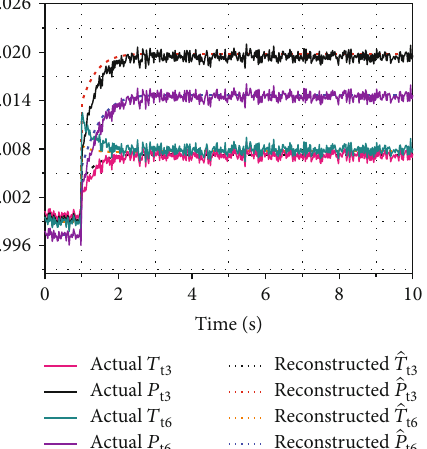
Figure 9: Comparison between reconstructed measurements and actual measurements.